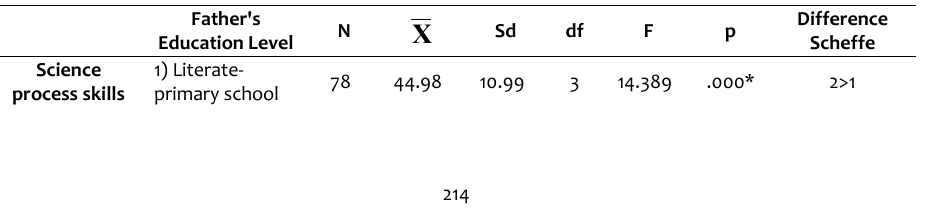
Table 16. Results of ANOVA on Science Process Skills of the 5-Year-Old Preschoolers According to Father's Education